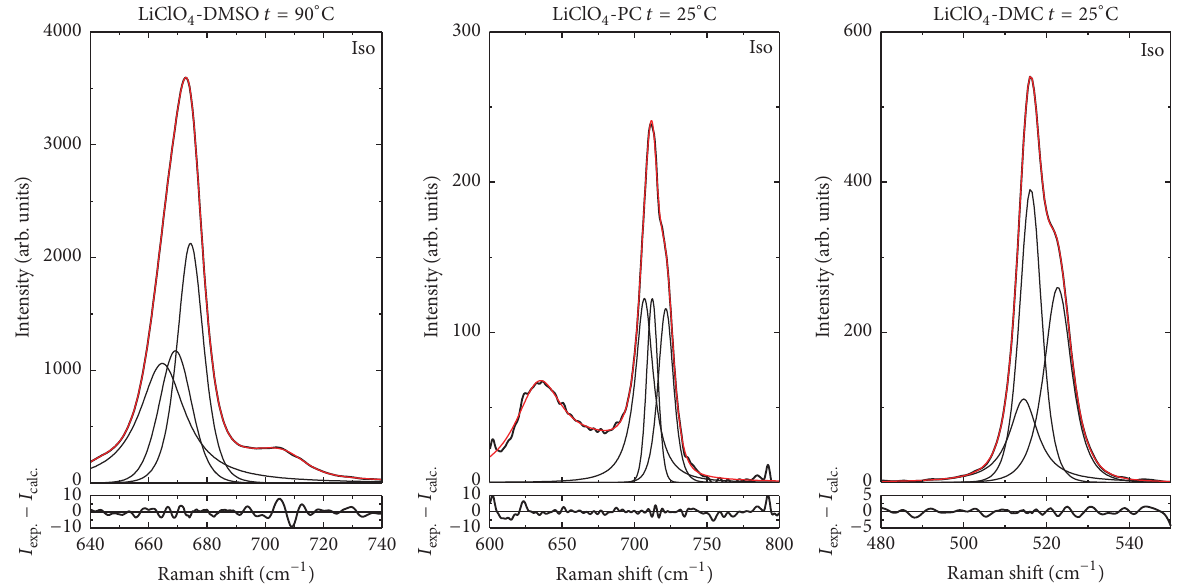
Figure 1: Raman spectra of DMSO, PC, and DMC solutions containing 0.15 mole fractions of LiClO 4 in regions sensitive to cation solvation effects.